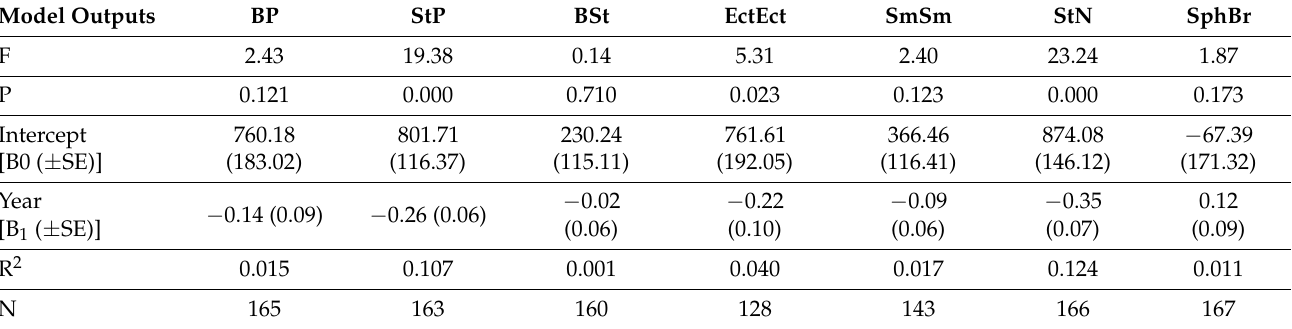
Table 1. Linear regression models of cranial dimensions change over time in males of European bison.